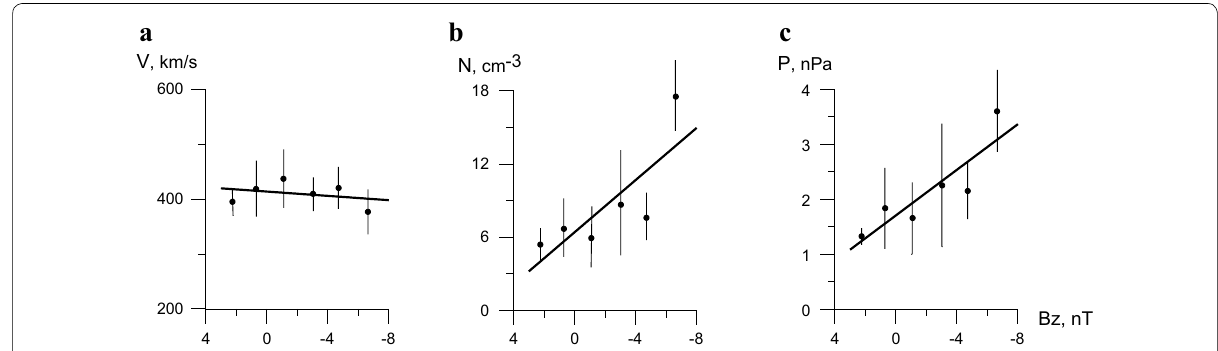
Fig. 3 Relationship between the solar wind velocity ( a ), plasma density ( b ) and dynamic pressure ( c ), and the IMF Bz component. The averaging is performed 1 h before the substorm onset. The vertical lines indicate the mean square deviation, and the solid lines represent the best linear fits